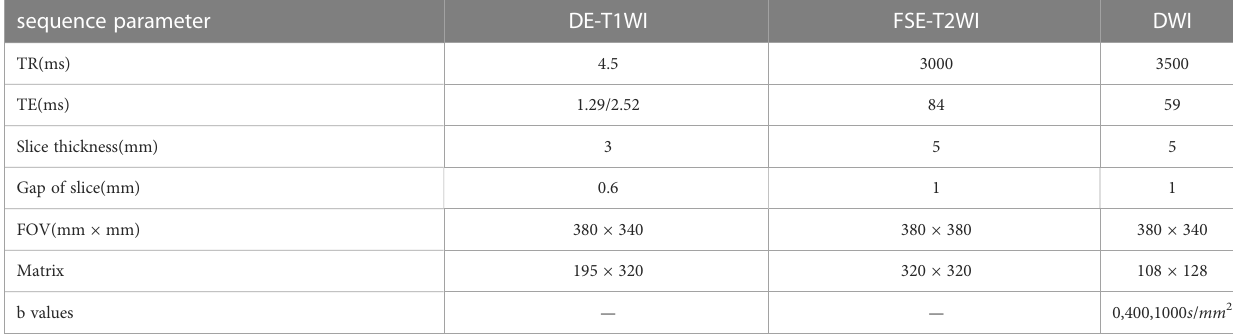
TABLE 2 Scan parameters of different routine MRI sequences. sequence